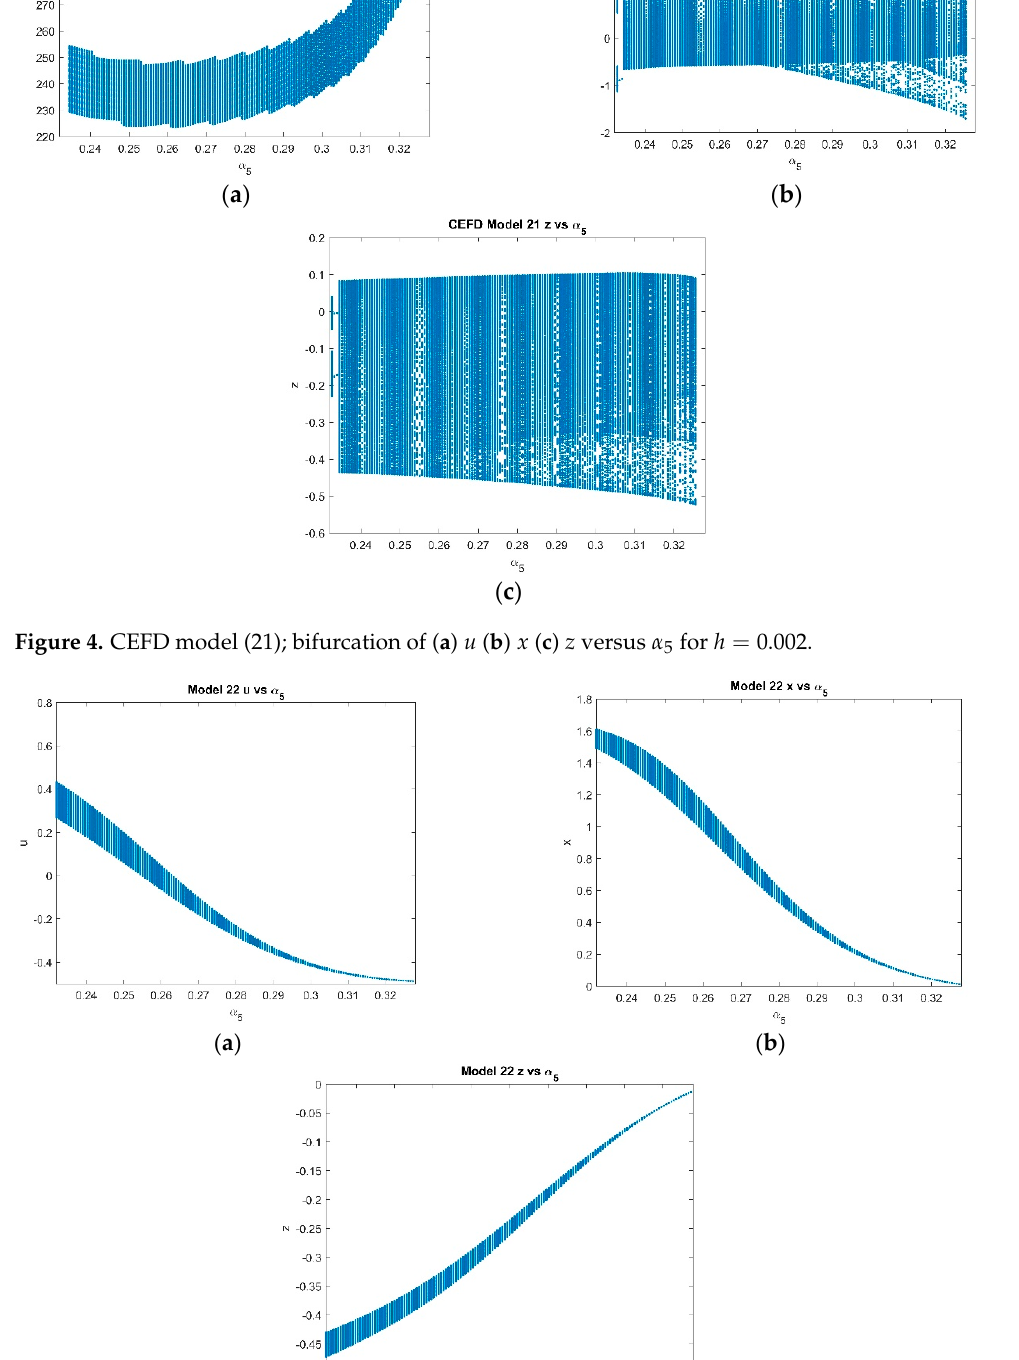
Figure 5. MCEFD Model (22); ( a ) u vs. α 5 , ( b ) x vs. α 5 , ( c ) z vs. α 5 , at k = 2, p = 1, α 5 ∈ [ 0.232, 0.328 ]